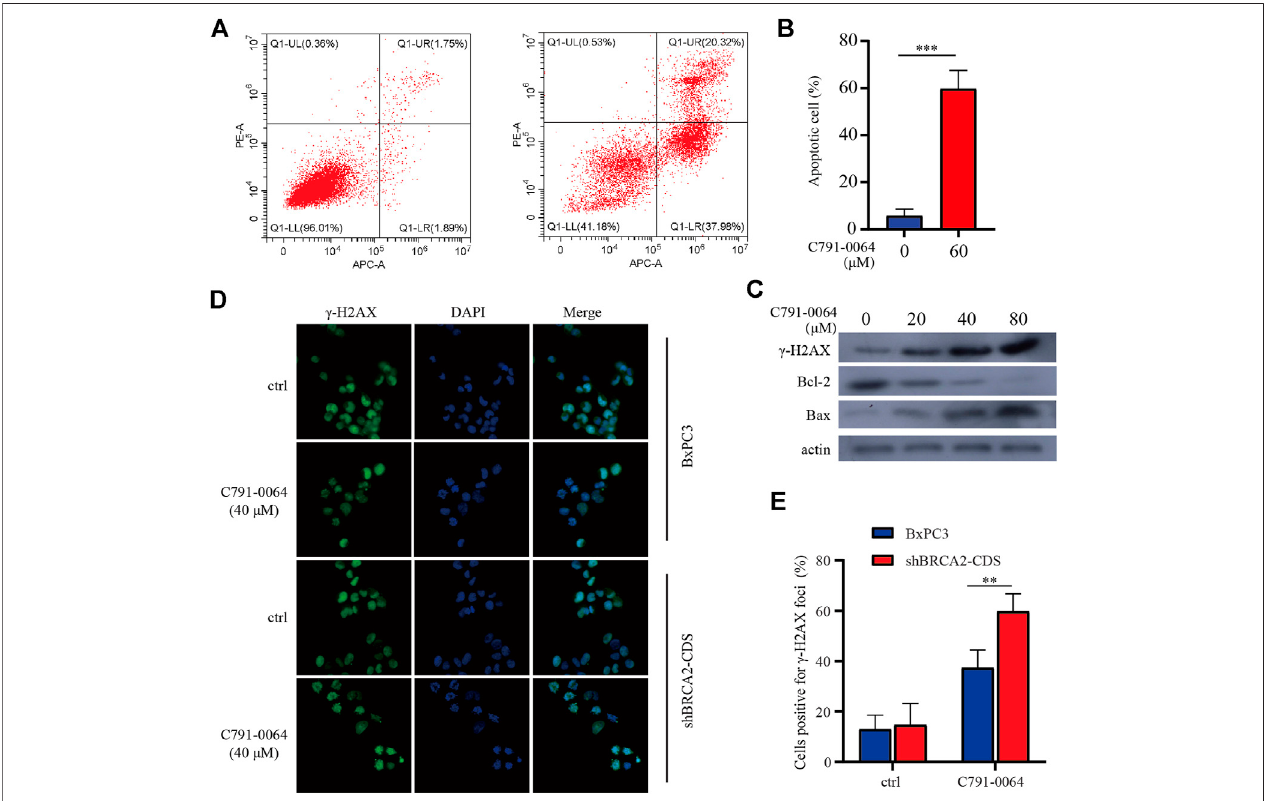
FIGURE5| C791-0064 causedapoptosisofBRCA2-de fi cient cells. (A) Flowcytometry detection ofapoptosis after 40 μ MofC791-0064 treatment ofshBRCA2- CDS BxPC3 cells for 48 h. (B) Quanti fi cation of apoptotic cell percentage ( n (cid:2) 3). (C) Western blot analysis of shBRCA2-CDS BxPC3 cells treated with different concentrations of C791-0064 for 48 h. (D,E) Immuno fl uorescence staining of γ -H2AX in shBRCA2-CDS BxPC3 and BxPC3 cells treated with 40 μ M of C791-0064 for 24 h and its quanti fi cation for cells positive for γ -H2AX foci ( n (cid:2) 3). Error bars represent for